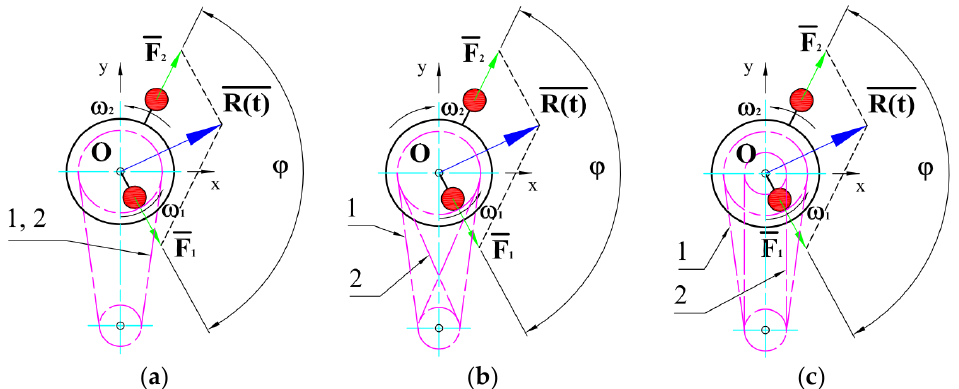
Figure 3. Schemes of kinematic synchronization of the unbalanced rotors of the inertial vibration exciter. ( a ) 𝜔 2 = 𝜔 1 ; ( b ) 𝜔 2 = −𝜔 1 ; ( c ) 𝜔 2 = 2𝜔 1 .